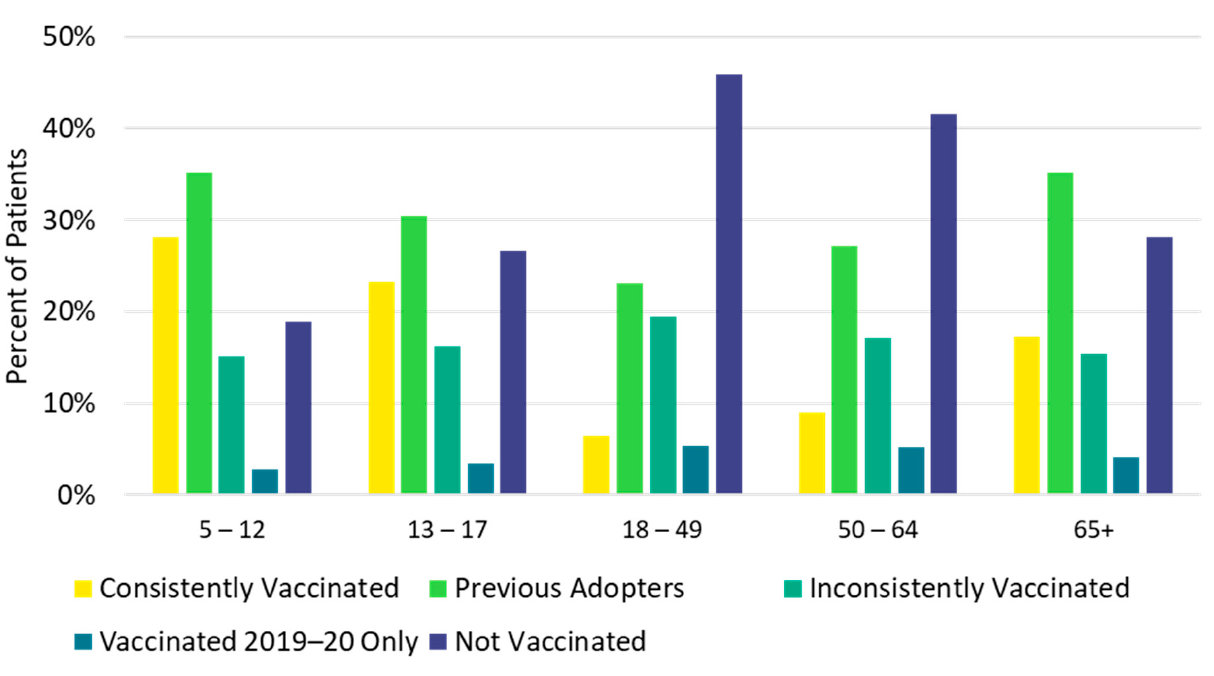
Figure 4. Vaccination history by age group: 2015–2016 through 2019–2020.